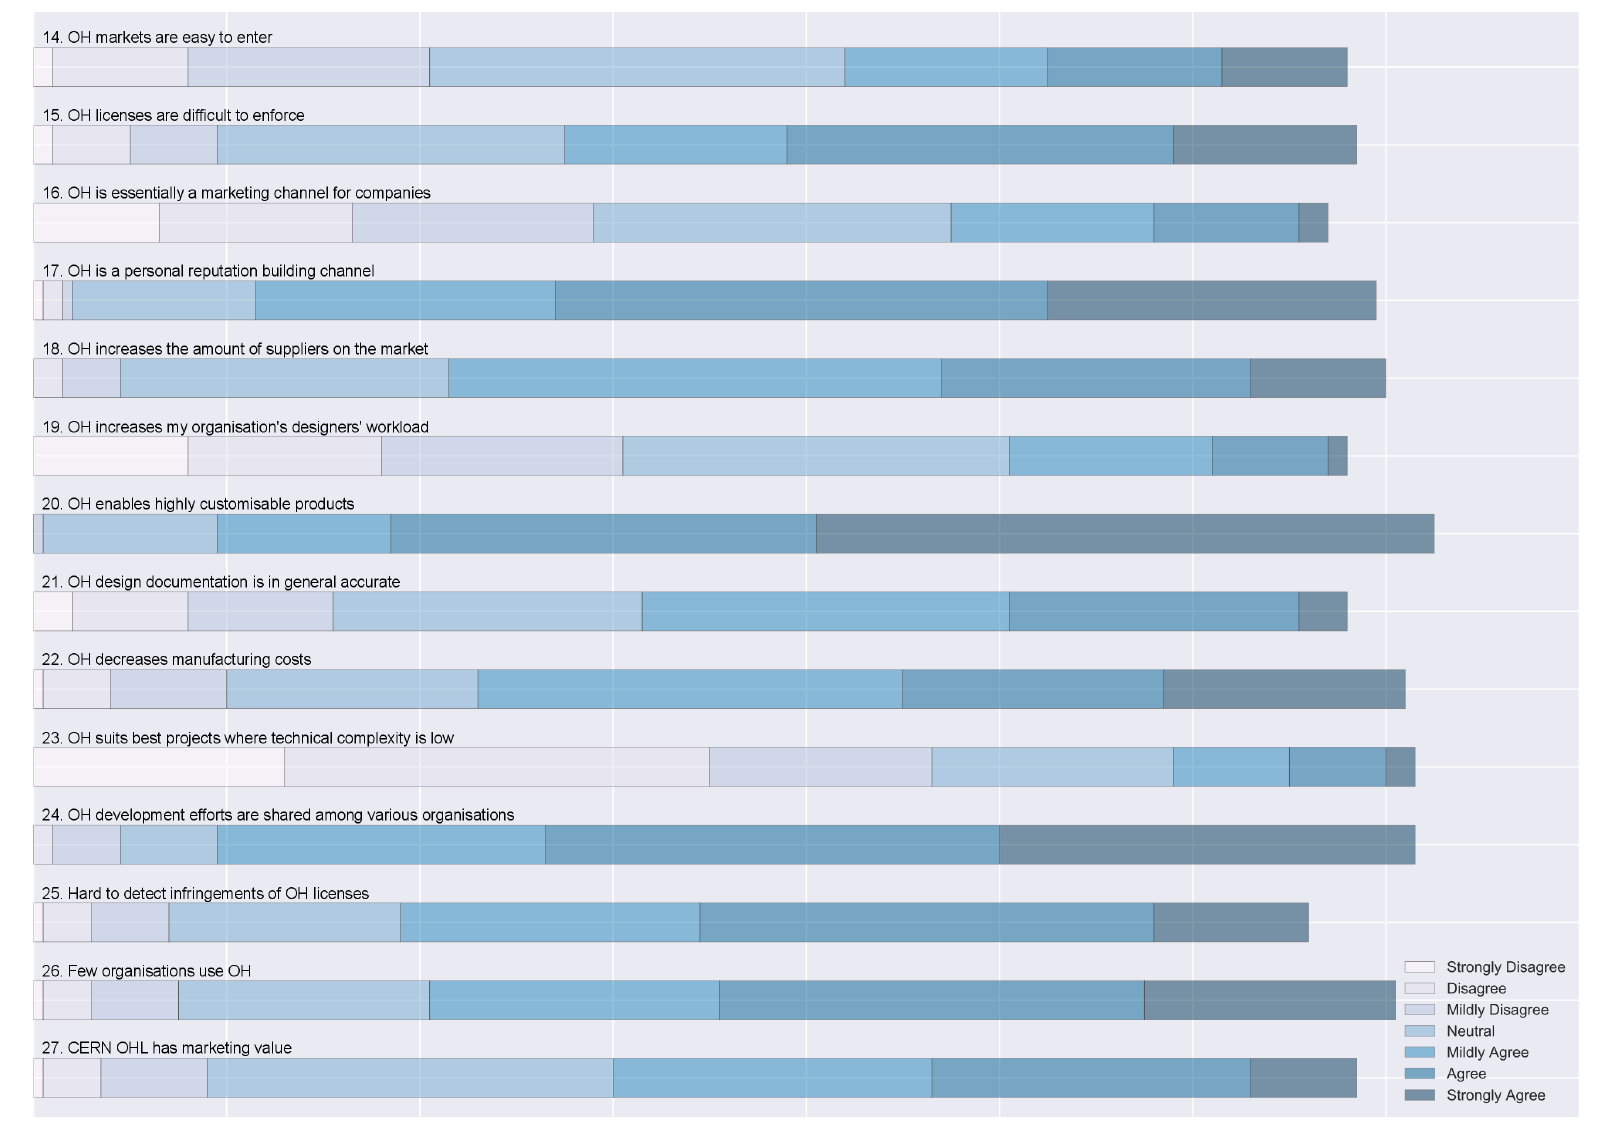
Figure 2b: Respondents' perceptions of common open hardware